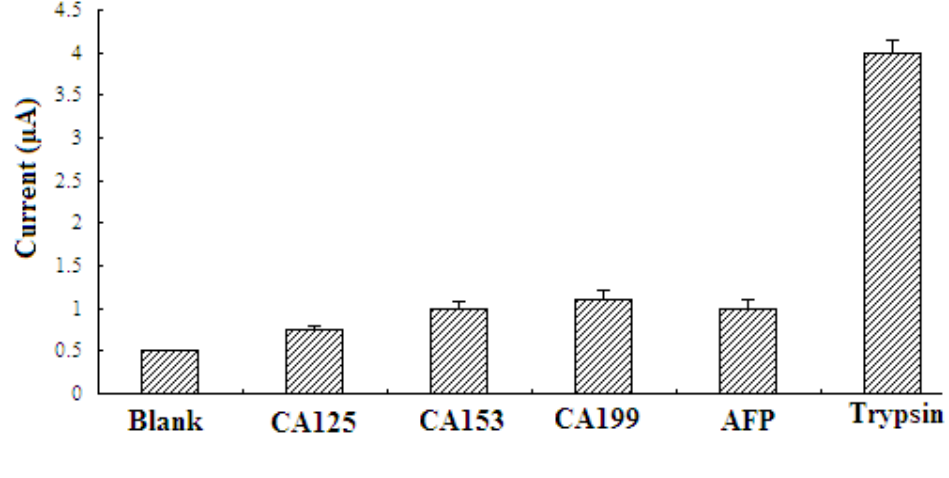
Figure 5. The specificity of the immunosensor tested the CV responsesto some common interfering proteins. Its CV responses to CA125, CA153, CA199, and trypsin were investigated under the same experimental